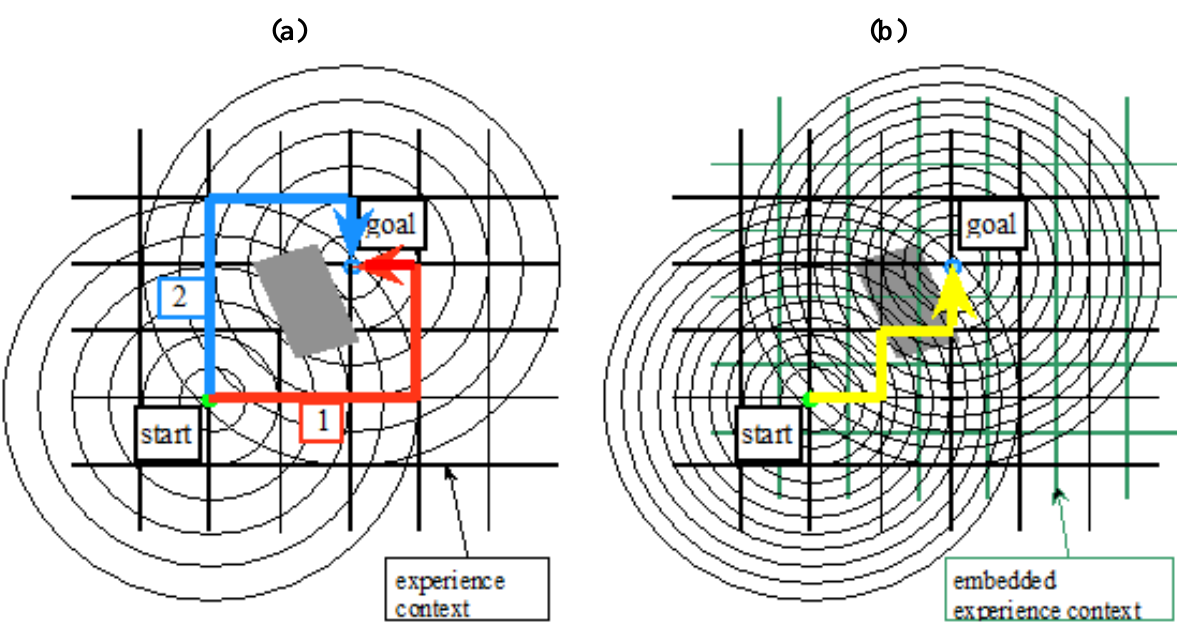
Figure 1. Activation paths in connectionist systems; the green grid ( b ) indicates the appearance of a new model; William Calvin discovered the recursive structure of this process from a language theoretical perspective